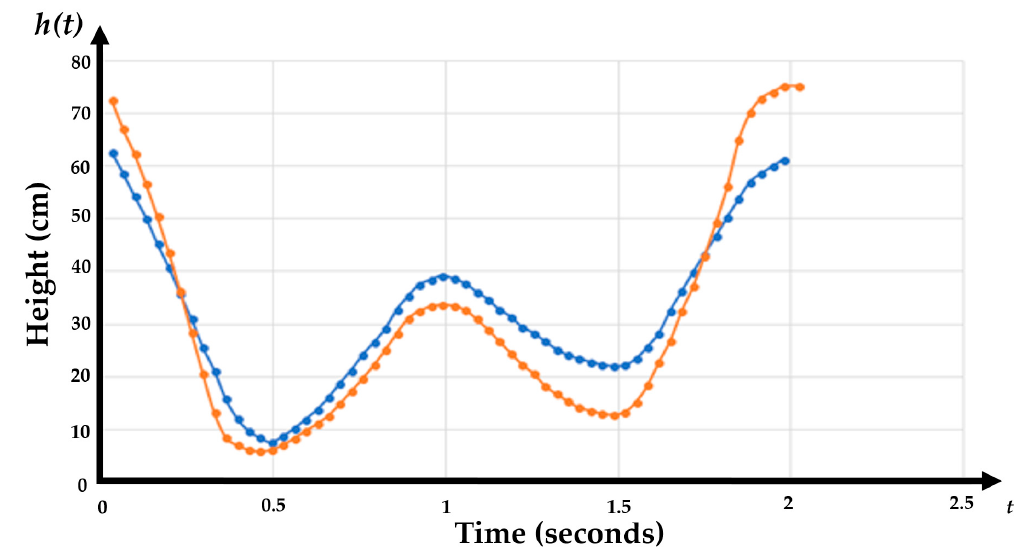
Figure 8. Both the template and user data graphed together, where the blue curve indicates the template gesture and the orange curve indicates the user gesture.